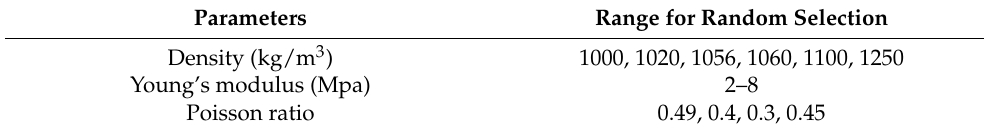
Table 2. Material properties of aortic valves.